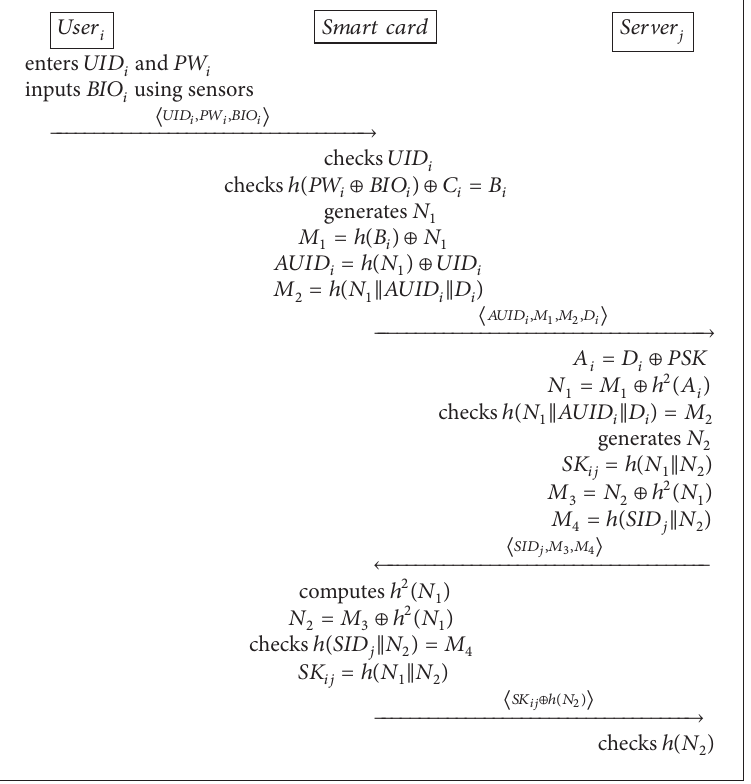
Algorithm 1: Login and authentication phase of Chuang and Chen’s scheme.